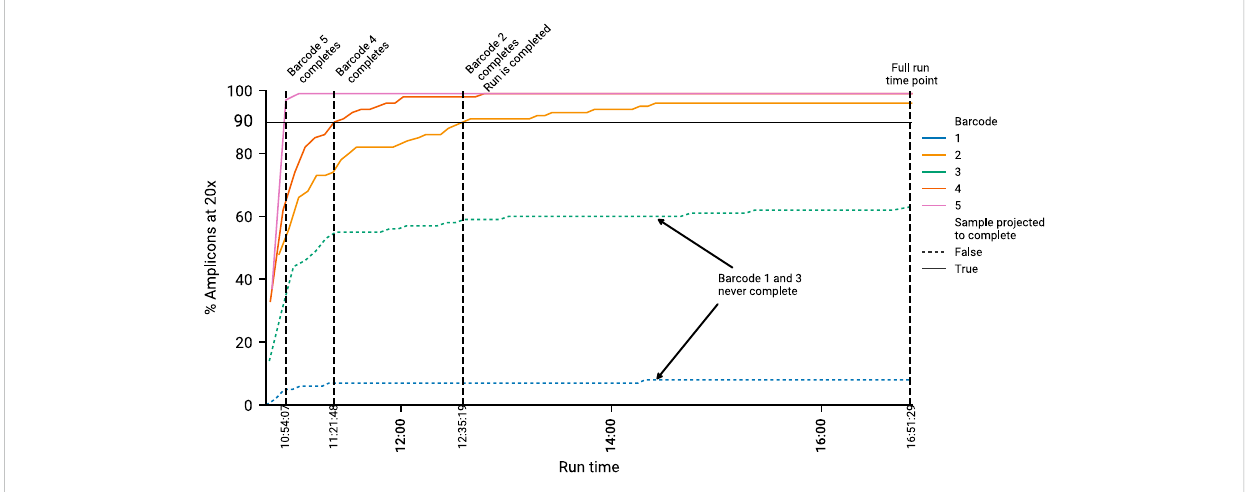
FIGURE 2 An example run, showing how timepoints are calculated. Five barcodes are displayed. Black horizontal line indicates the 20× coverage on 90% of ampliconsthreshold.Thetimeatwhichabarcodereachesthisthresholdisrecordedasthe “ SampleCompletion ” (SC)timepoint.Twoillustrativesamples, barcode1and3,arenotpredictedto fi nish,anddonotcrossthisthreshold.HencetheyhavenoassociatedSCtime.Onceallbarcodespredictedto fi nish are complete, we record the “ Run Completed ” (RC) time point. This is the time minoTour would recommend stopping the run. The Full Run time is when the run stopped without any early